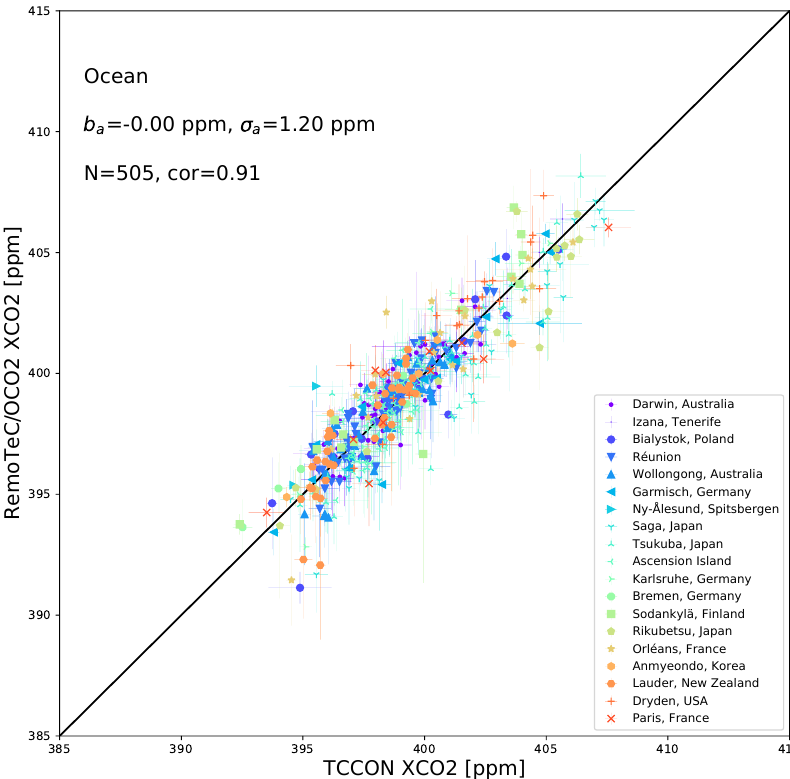
Figure 7. Same as Fig. 5, but for OCO-2 ocean type measurements obtained under glint mode.